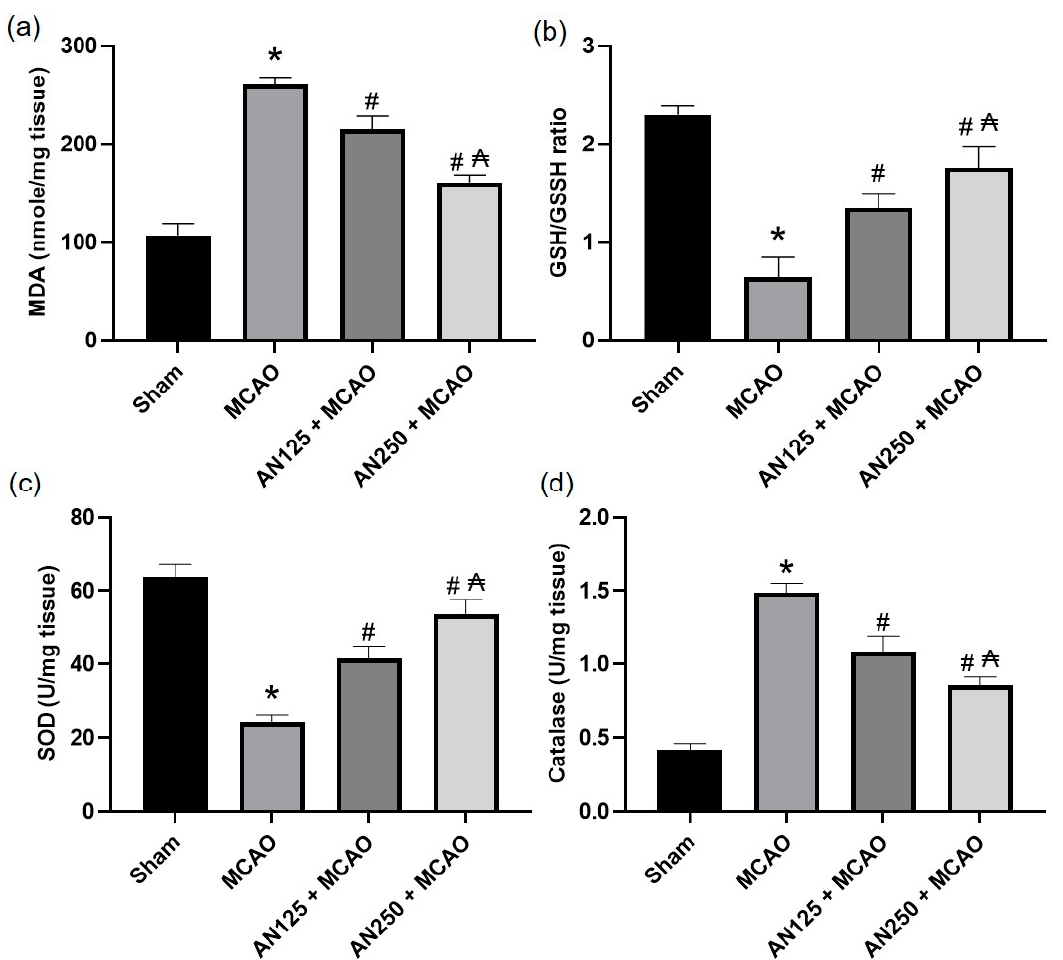
Figure 1. The impact of pretreatment with anethole (AN, 125 and 250 mg/kg, orally) for two weeks in MCAO-induced cerebral ischemia/reperfusion on ( a ) infarct volume, ( b ) neurological deficits, ( c ) Evans blue concentration and ( d ) brain water content percentage. Data are expressed as mean ± SD ( n = 6). * significantly different from the sham-operated group, # significantly different from the MCAO ischemic group, and ₳ significantly different from the AN125 + MCAO group at p < 0.05 using ANOVA followed by Tukey ’ s post hoc